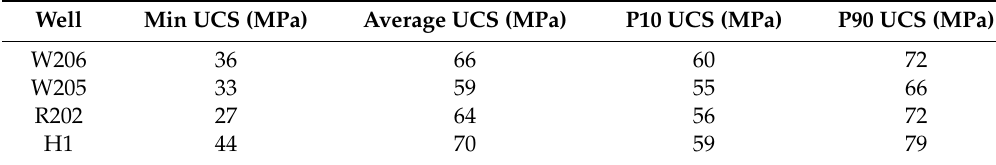
Table 3. Comparison of rock uniaxial compressive